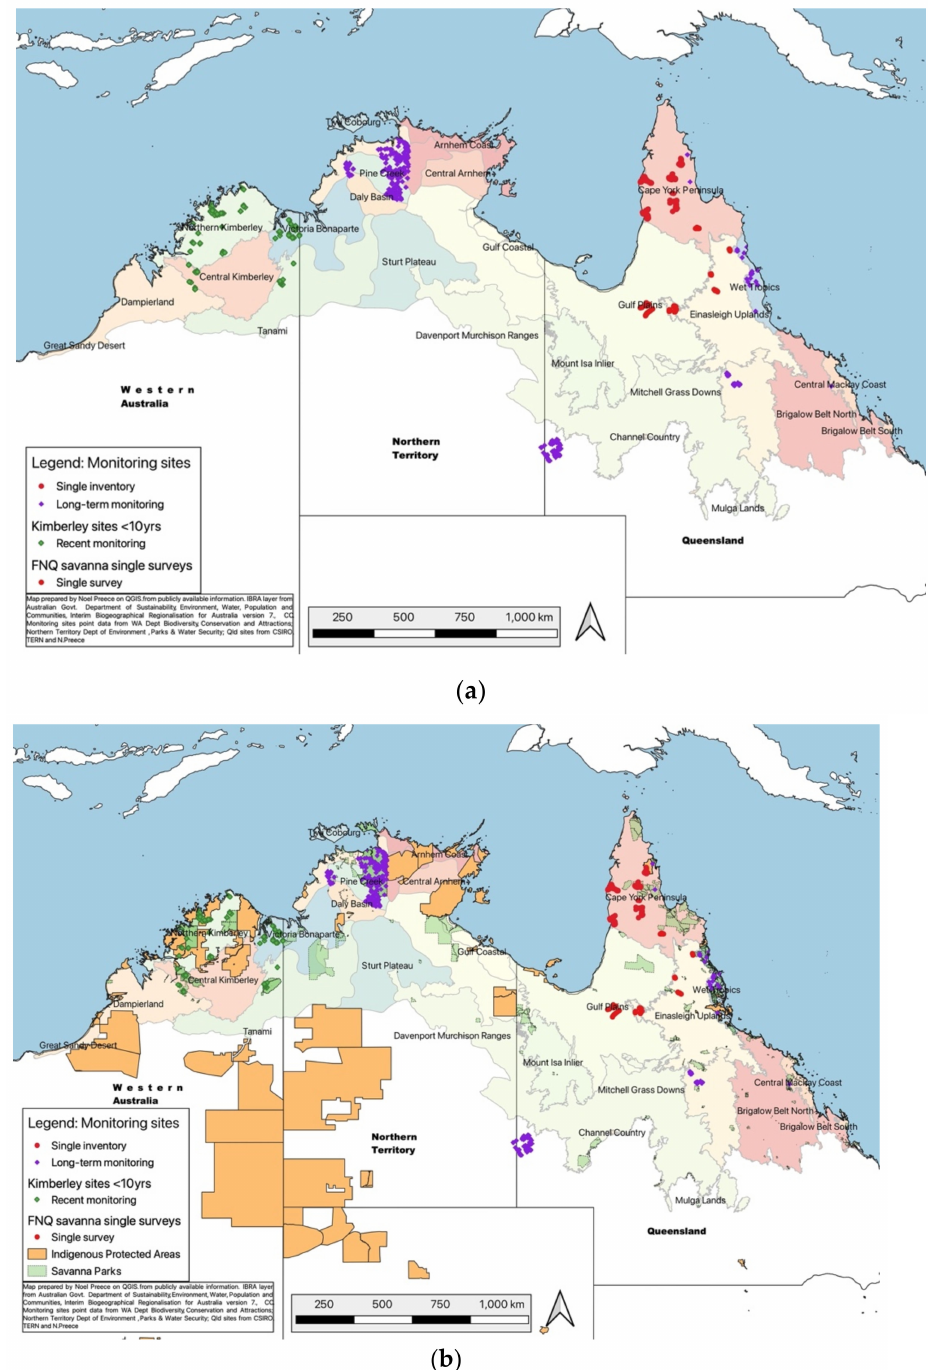
Figure 3. Monitoring sites across the north Australia savanna region, showing ( a ) IBRA bioregions, and ( b ) public protected areas (‘Savanna Parks’) and Indigenous Protected Areas. Sites marked with purple diamonds are long-term monitoring sites, green diamonds are medium-term monitoring sites, and red circles are single survey sites (sites do not include private conservation areas). The Wet Tropics (coastal north-east Queensland) are excluded as there are monitoring and research sites in the region operated by a number of